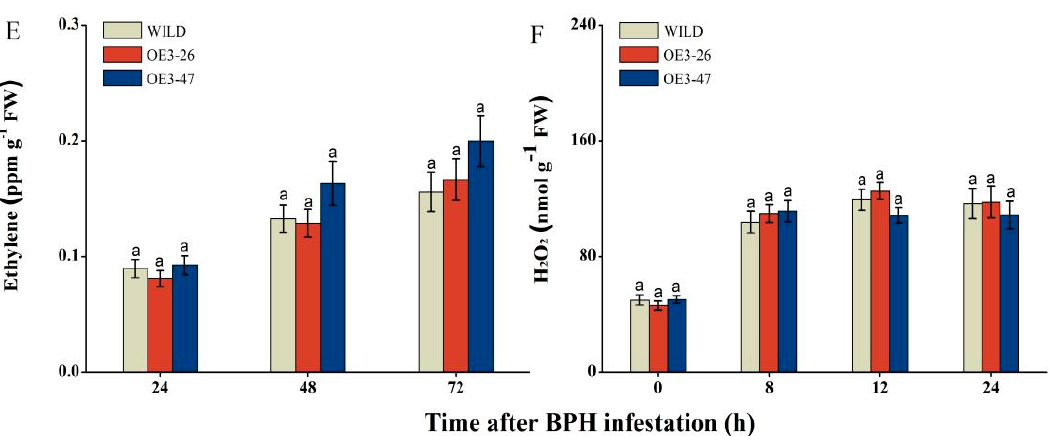
Figure 5. OsMKK3 mediates the levels of jasmonic acid (JA), jasmonoyl-L-isoleucine (JA-Ile), abscisic acid (ABA), and salicylic acid (SA), but not ethylene and H 2 O 2 in response to BPH. Levels (mean ± SE, n = 6) of JA ( A ), JA-Ile ( B ), ABA (C) , SA ( D ), ethylene ( E ), and H 2 O 2 ( F ) in overexpressed lines (OE3-26, OE3- 47) and wild-type plants (WILD) after infestation of 15 gravid BPH females. Di ff erent letters refer